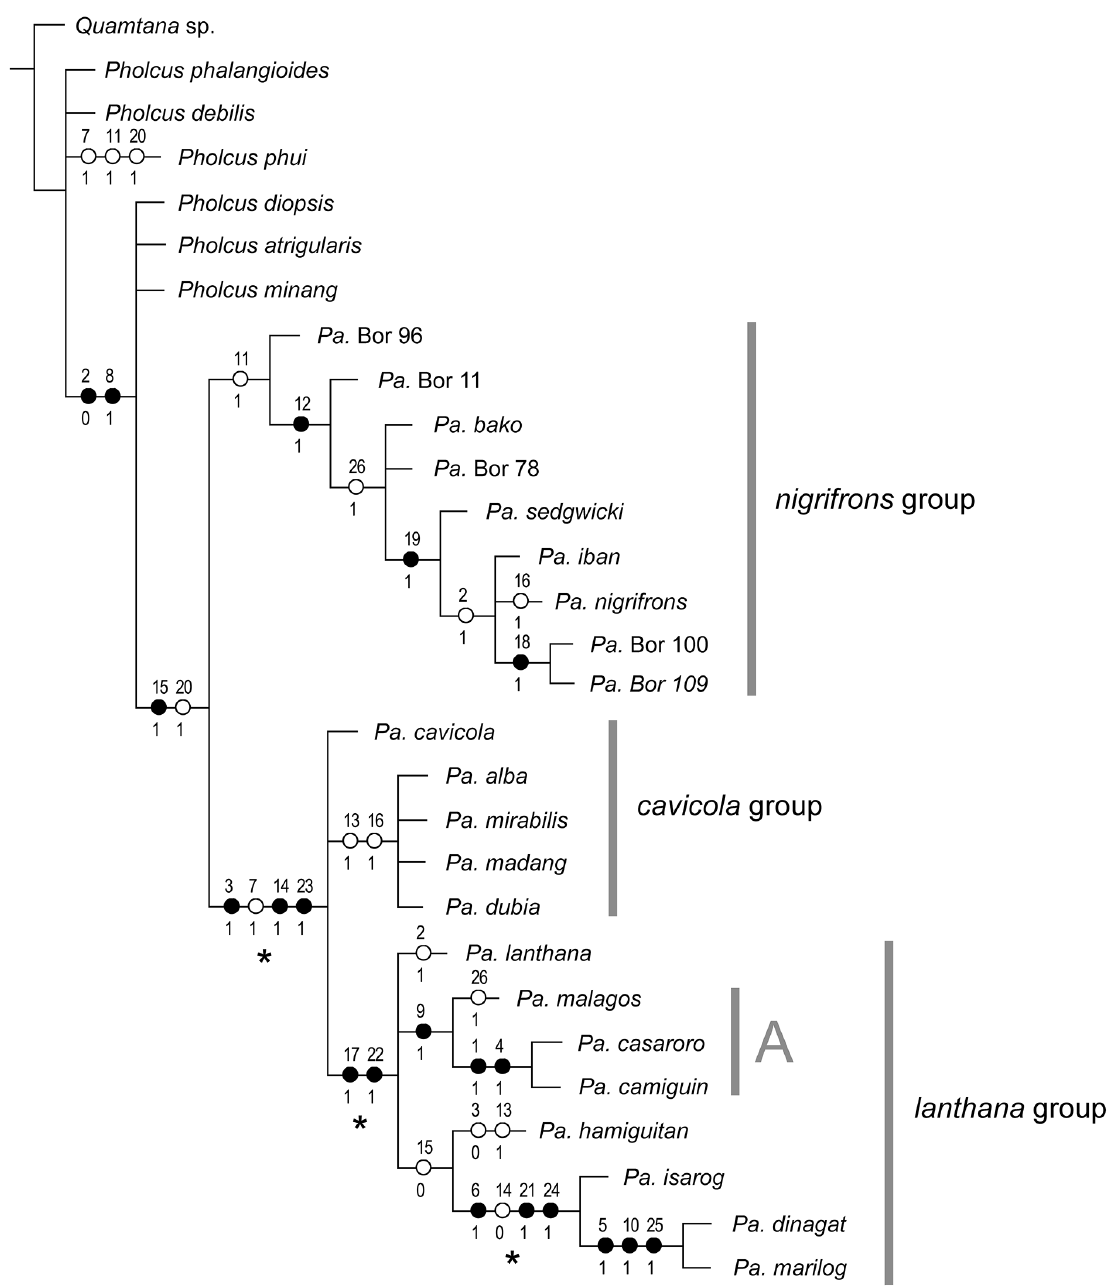
Fig. 1. Strict consensus of two most parsimonious cladograms of Panjange Deeleman-Reinhold & Deeleman, 1983 resulting from analyses of the matrix in Appendix 1 using equal character weights, successive weighting, and implicit enumeration. Only unambiguous character changes are shown. A = clade with asymmetric male palps; * = positions of Pa. bukidnon Huber sp. nov. in preliminary cladistic analyses. See Cladistic analysis section for further